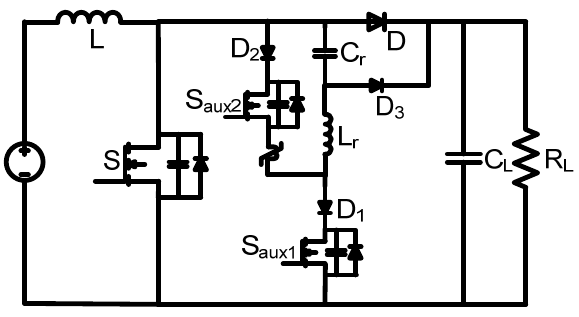
Figure 4. Proposed DC-DC boost converter.